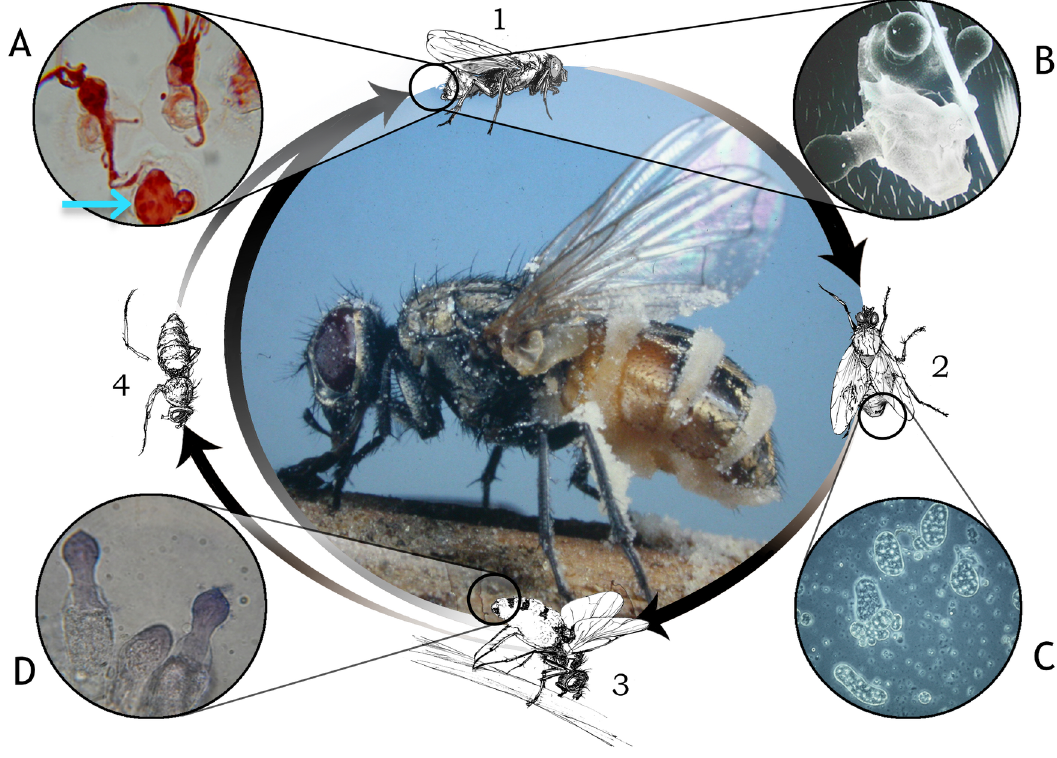
Fig 1. Life cycle of Entomophthora muscae infecting a muscoid fly. Beginningof infection (1, top). Germinationof multinucleate primary infectiousconidiaon multiple locationson the host surface, producinghyphaeand secondary conidium(A) or multiple secondary conidia(B). Infected fly in an intermediate stage of incubation (2) with interior hyphal bodies in insect blood and tissues within the body cavity (C). Death grip of actively sporulating cadaver (3); fungal conidiophores with youngprimary conidiaemerging from membranous areas of host abdominalcuticle (D). Mummified fly cadaver (4) as a potential reservoir for overwintering resting spores. Center: House fly after most conidialdischargeis complete. Note lifelike stance, with extendedwings, legs, and mouthparts and sticky conidiaadheringto legs, wings, and substrate. Photographs: BradleyMullens, Max Badgley, and Andrii Gryganskyi; drawingsby DanniWei, student artist at UC